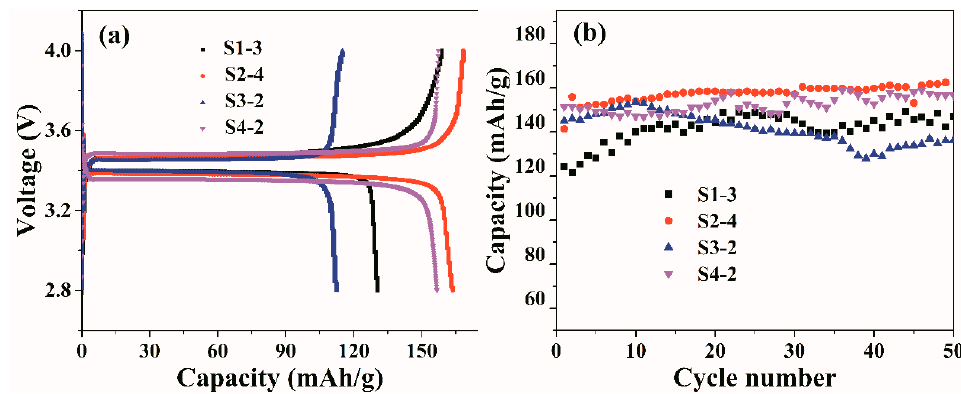
Figure 7. Initial charge-discharge capacities at 0.1 C rate ( a ) and cycling performances at 0.2 C rate ( b ) of GPEs prepared by different mixed solvents.